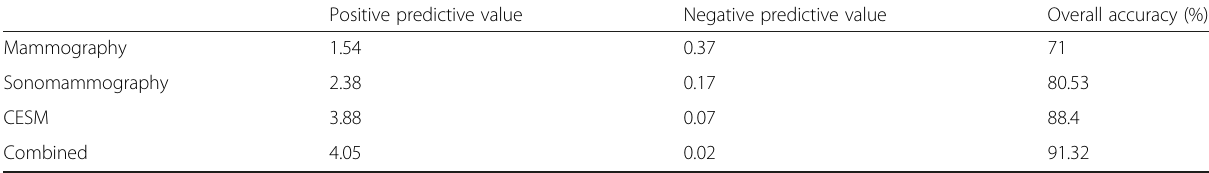
Table 4 The positive predictive value, negative predictive value, and overall accuracy of different imaging modalities in assessment of breast